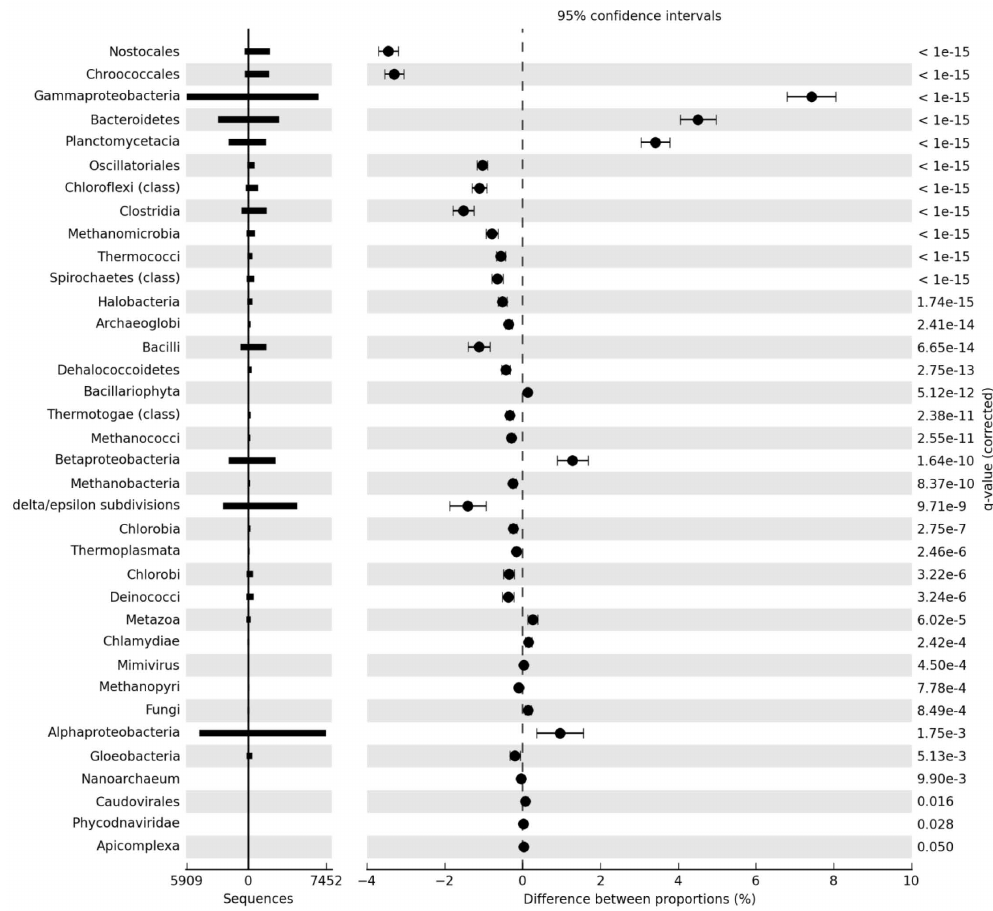
Fig. 4. Taxa enriched or depleted in the 37 and 136 metagenomes. Corrected P-values were calculated using Storey’s FDR approach. Taxa enriched in the marine (37) metagenomes have positive differences between